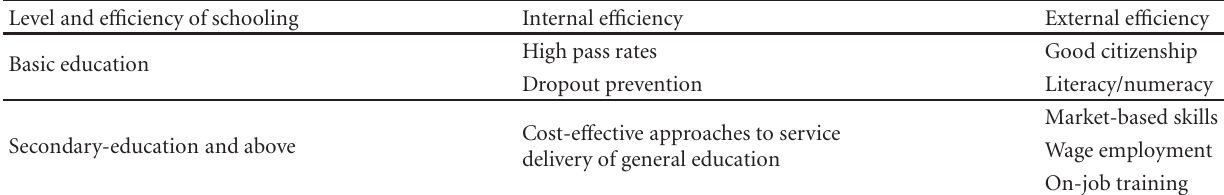
Table 1: Educational finance paradigm.